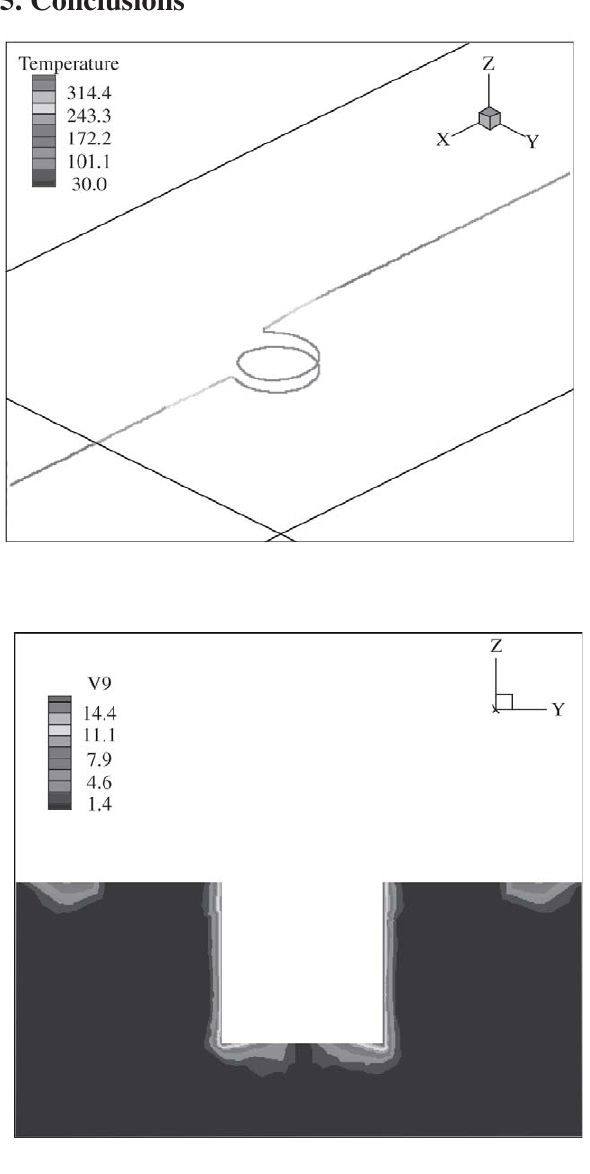
Figure 4. Velocity module in planes XZ and